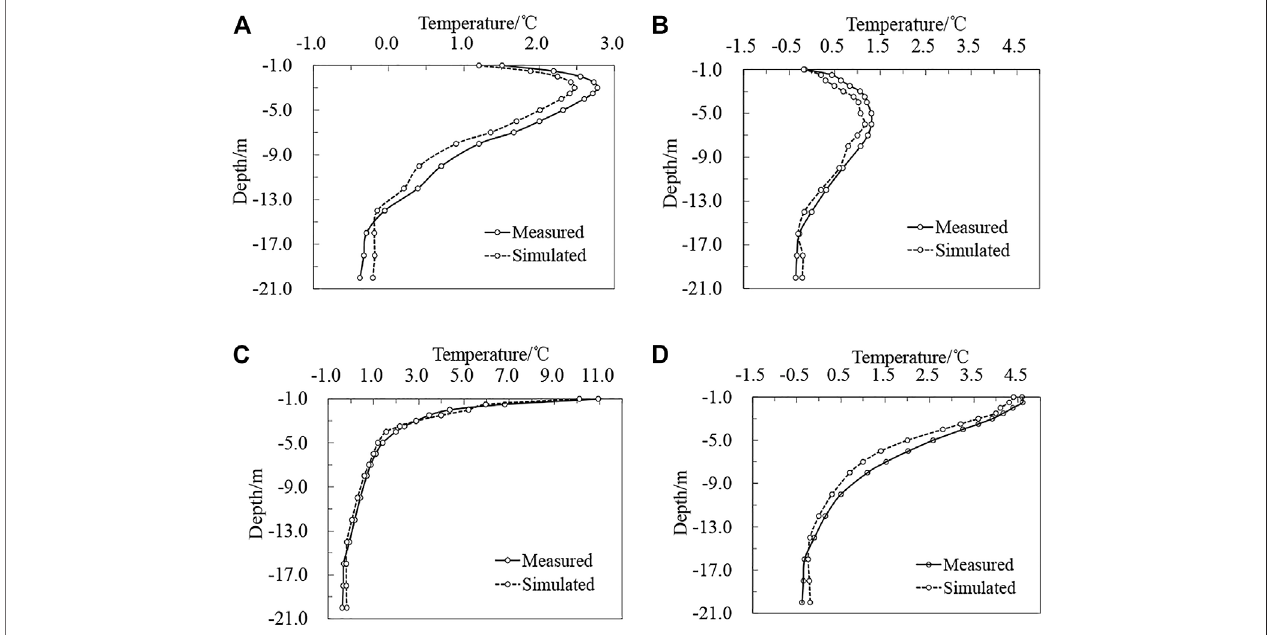
FIGURE 9 | Comparison of the measured and simulated values of the permafrost temperature under the thermokarst lake water in January, April, July, and October, 2014. (A) January. (B) April. (C) July. (D) October.